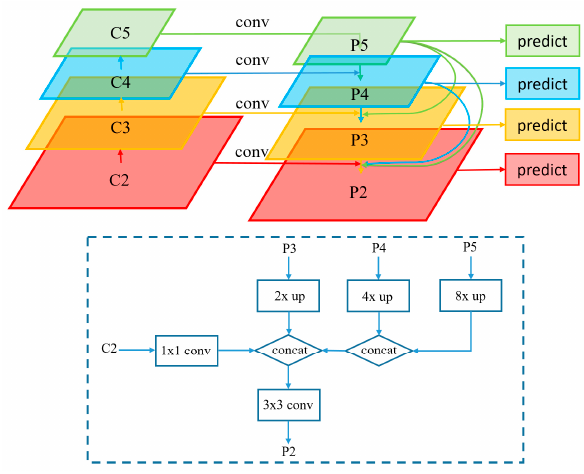
Figure 3. A multiscale feature pyramid connection. Each feature map is densely connected, and merged by concatenation.